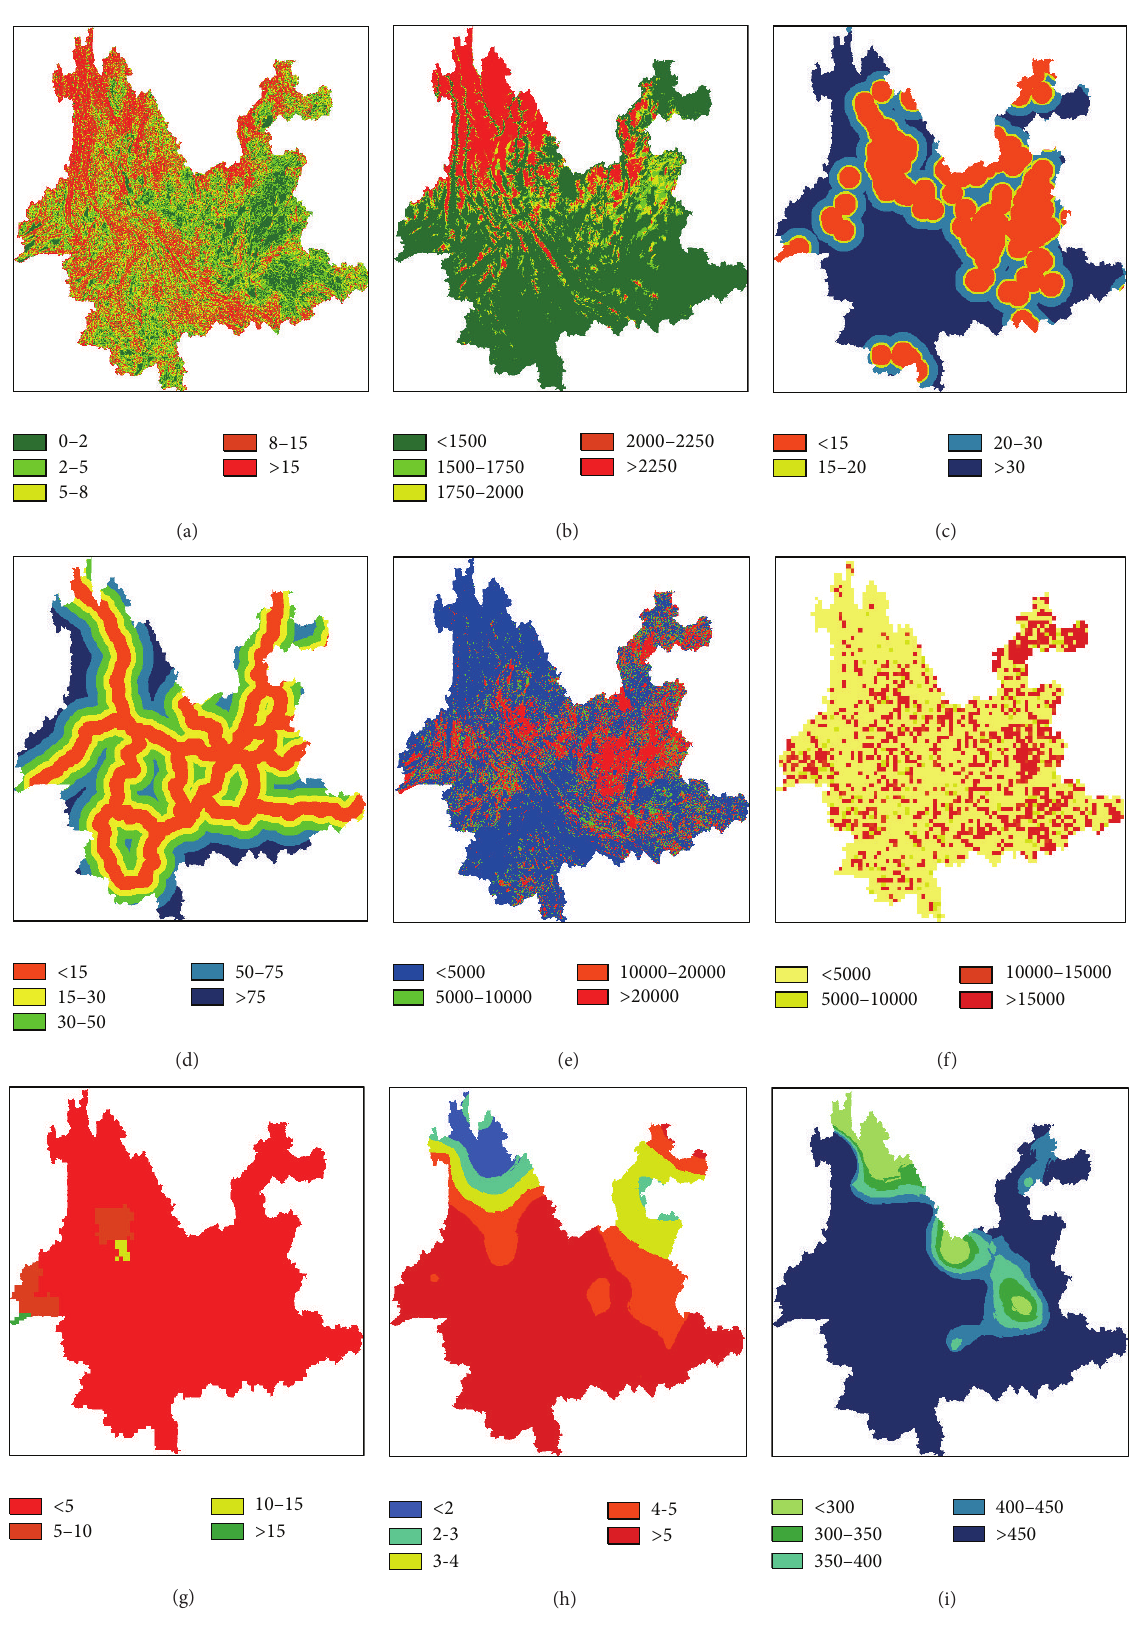
Figure 4: Nine-factor maps. (a) Slope ( ∘ ); (b) elevation (m); (c) distance to water (Km); (d) distance to state roads (Km); (e) GDP per capita (Yuan); (f) population (person); (g) proportion of plain areas (%); (h) annual average temperature ( ∘ C); (i) annual rainfall